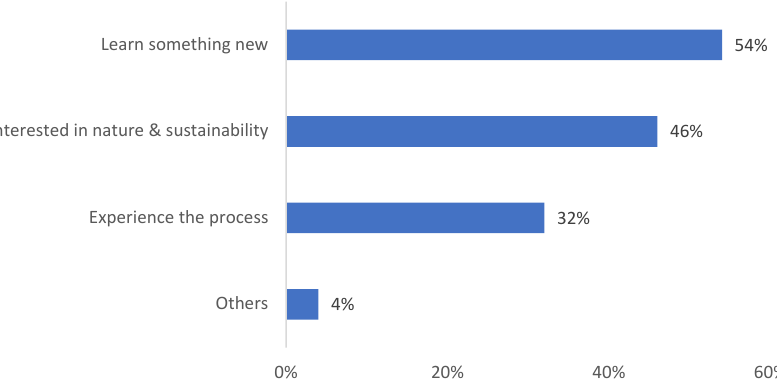
Figure 14. Student responses to the reasons for choosing the N&A module.